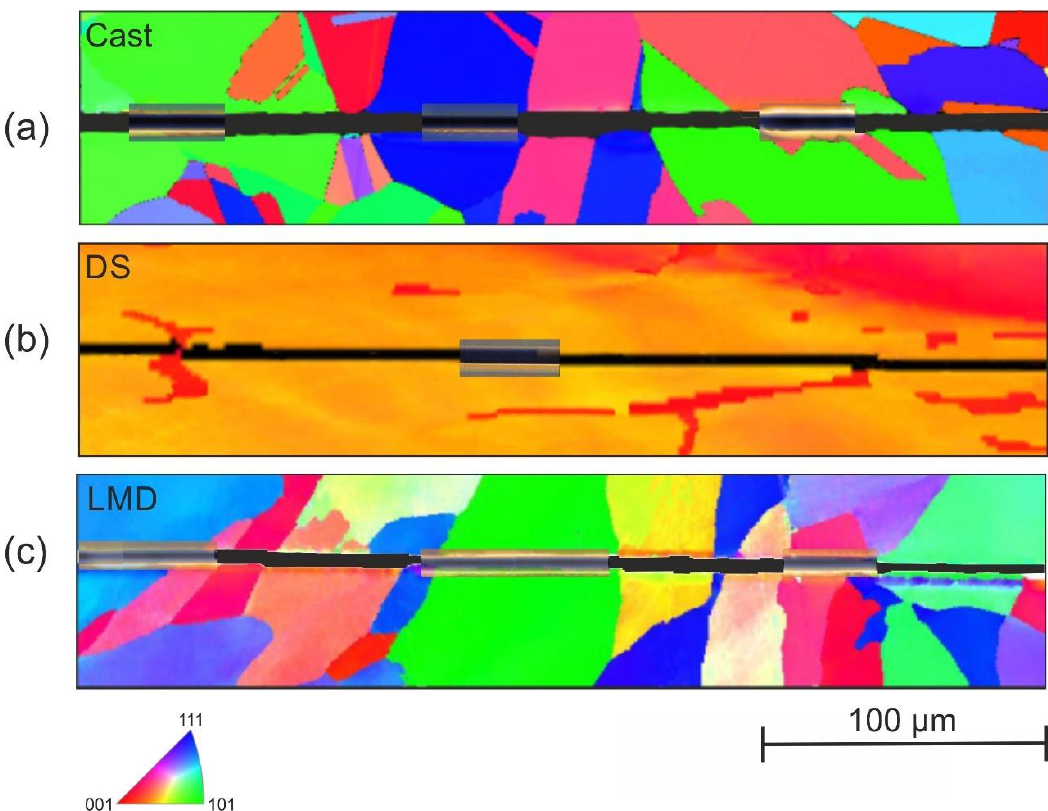
Figure 8. EBSD images of the investigated microstructures after scratching with a spheroconical diamond tip ( r = 10 µm) and a normal load of 50 mN with qualitative superimposition of atomic force microscope (AFM) topography images at different positions along the scratch groove.